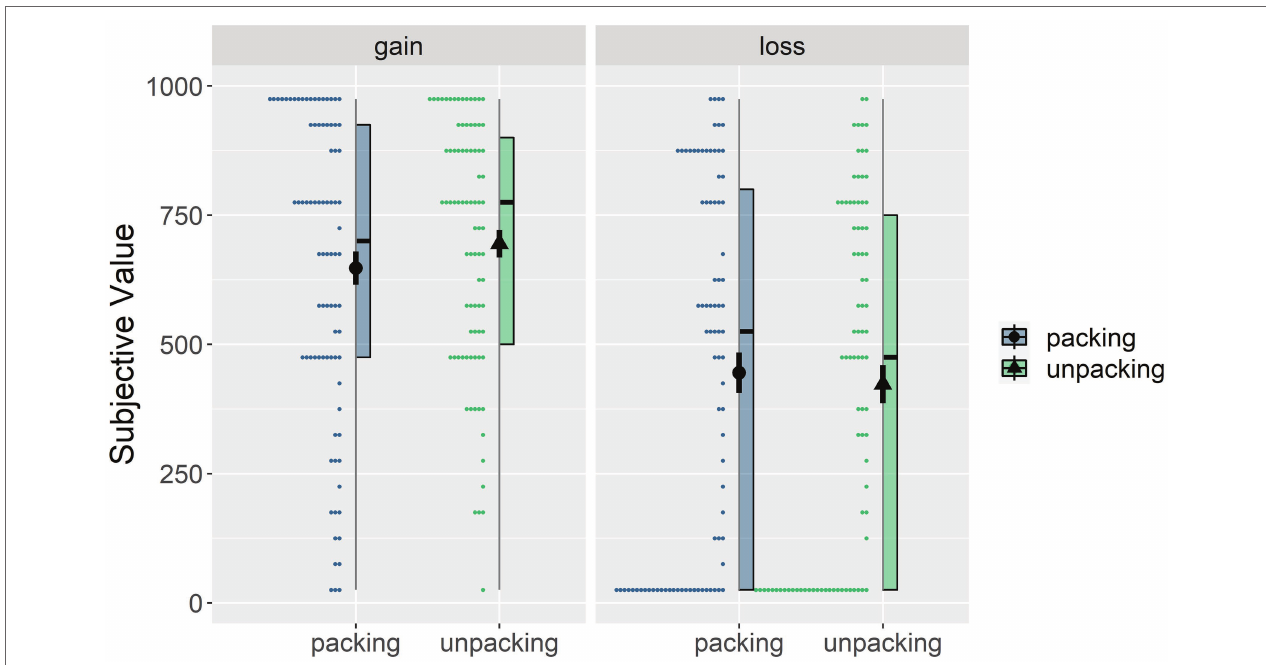
FIGURE 2 | The interaction effect of time unpacking (packing vs. unpacking) and choice valence (gain vs. loss) on the subjective values of delayed choices. The points in the figure represent the results of each trial. The line is the range of dependent variables. The colored rectangles represent the 25, 50, and 75% quartiles, respectively, and the black dots and line segments represent the mean and